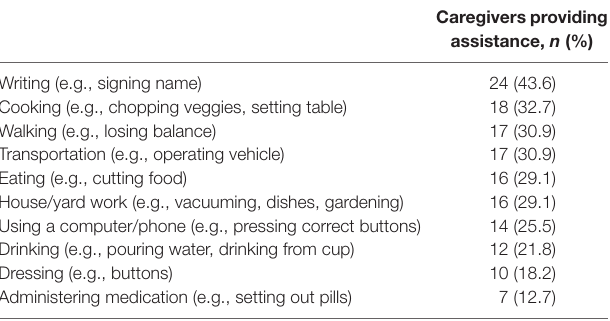
TaBle 2 | Tasks of daily living with which ET caregivers provide